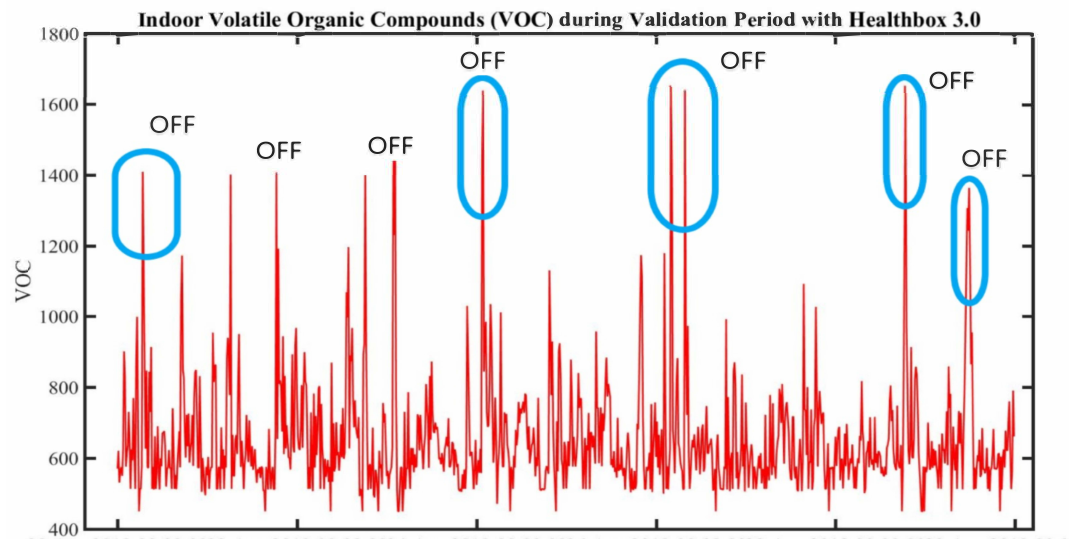
Figure 11. The Total Volatile Organic Compound levels with Hybrid Ventilation